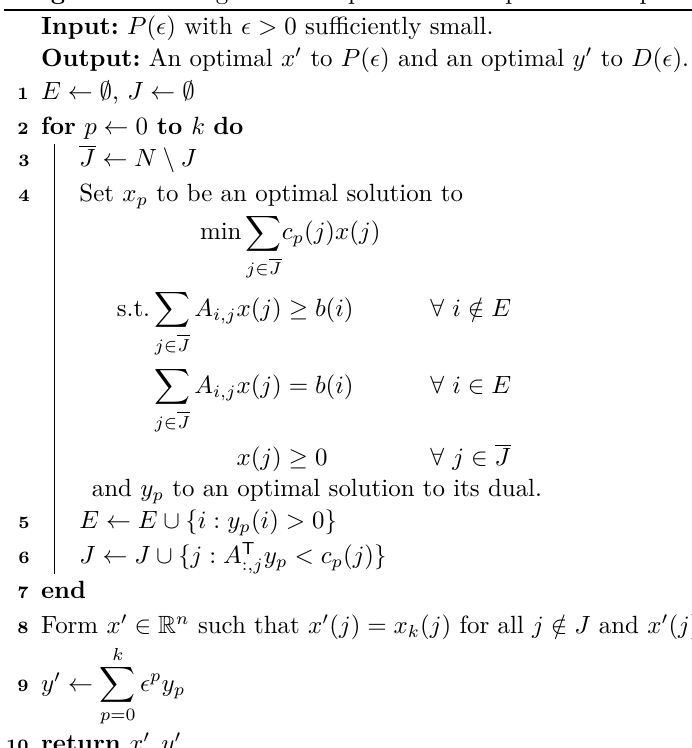
Algorithm 3: Algorithm for perturbed LP primal-dual